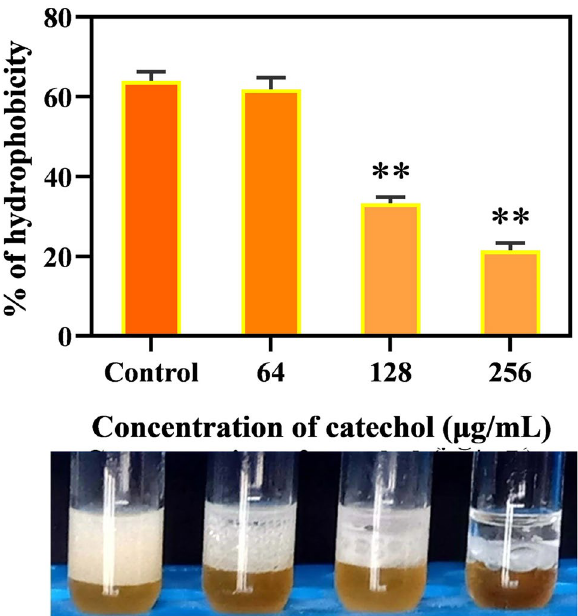
Figure 8. Effect of catechol at its sub-MIC on the C. albicans cellular surface hydrophobicity after grown for 24 h. Error bars indicates the mean values of three experimental triplicates. The “* “and “**” symbols represents the statistical significance of p < 0.05 and p < 0.01, respectively.